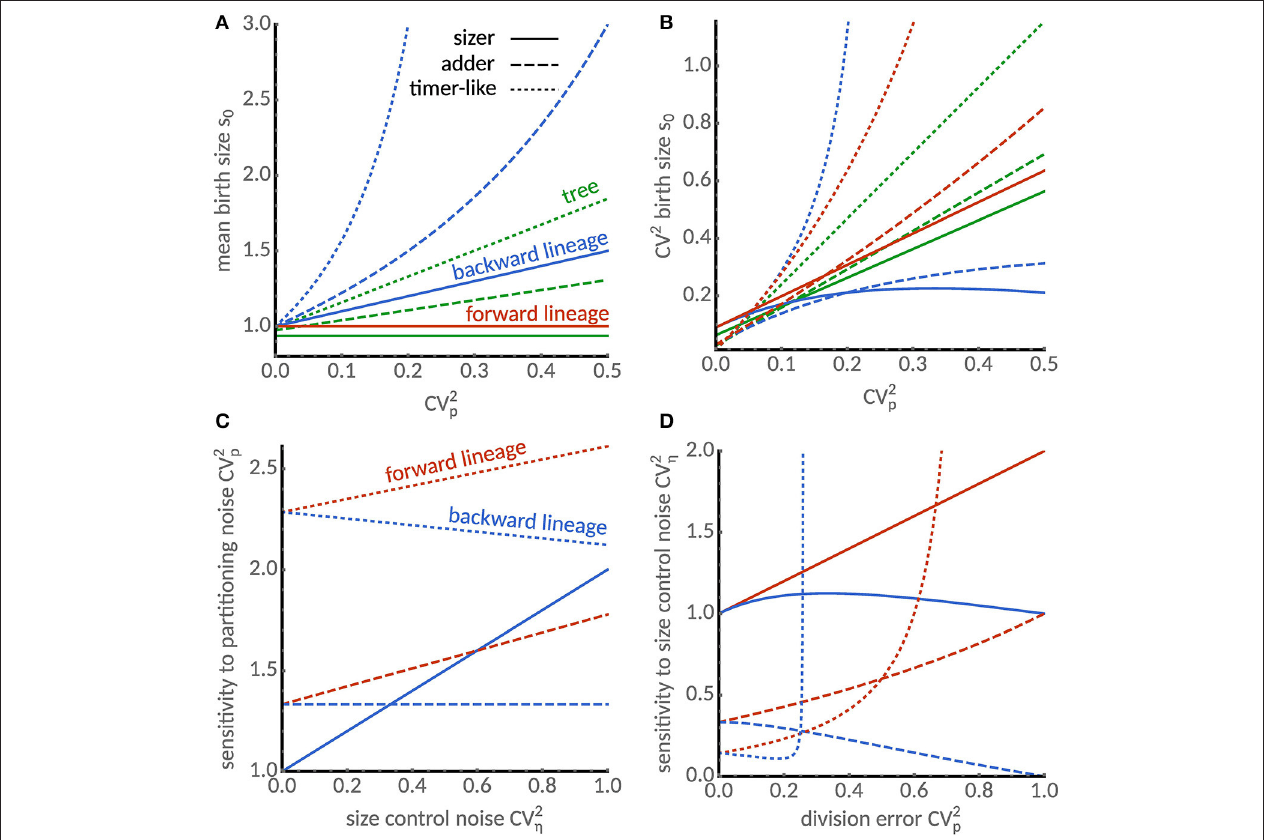
FIGURE 2 | Cell size statistics and their sensitivities differ between single cells and populations. (A) Mean birth size increases with division errors in backward lineages (blue) but not in forward lineages (red). In the tree statistics, mean birth size can be smaller or larger than in forward lineages depending on partition errors. Predictions for various modes of cell size control are shown: sizer ( a = 0, solid), adder ( a = 1, dashed) and timer-like ( a = 1.5, dotted). We chose E [ η ] = (2 − a ), CV η = 0.3 and skew[ η ] = 1 such that the mean cell size in forward lineages is independent of the cell size control. (B) Comparison of coefficients of variation of birth size in forward (blue), backward lineages (red) and lineage tree (green). For the sizer and adder mechanisms the size fluctuations in backward lineages and the tree statistic are always smaller than in forward lineages. (C) Sensitivity of the coefficient of variation of cell size to division errors in forward and backward lineages. Sensitivity increases with noise in cell size control in forward lineages (red lines) for all size controls. However, in backward lineages the sensitivity increases for the sizer, is constant for the adder and decreases for the timer-like control. (D) Sensitivity of the coefficient of variation of cell size to noise in size control. For small division errors, sensitivity of the sizer increases both in forward and backward lineages and the sensitivities of adder and timer-like controls display opposite behaviors in forward and backward lineages. Note that sensitivities diverge for the timer-like controls with large division